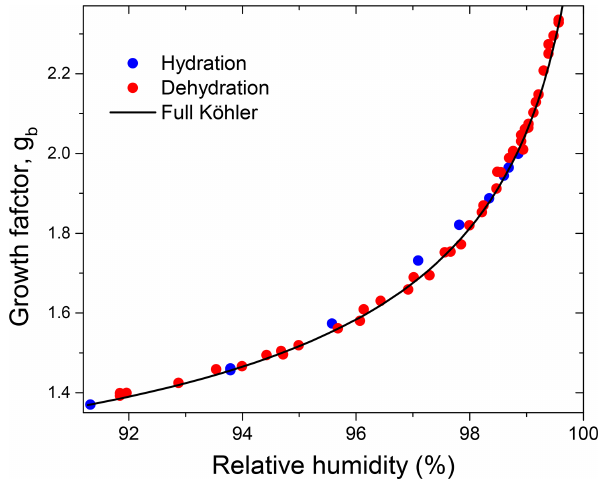
Figure 10. Growth factors observed in the hydration and dehy- dration experiments for the preconditioned glucose aerosol parti- cles with D b, H&D , min = 99 . 6nm in comparison to mass equivalent growth factors calculated with the full Köhler